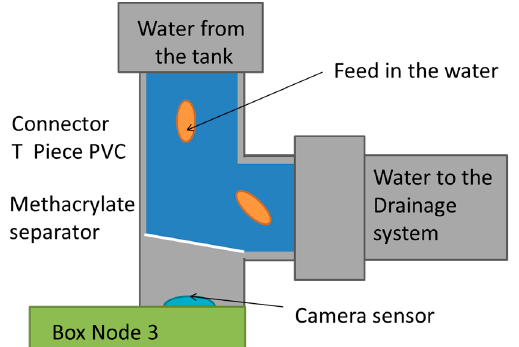
Figure 8. Detail of the location of feed fallen detector.